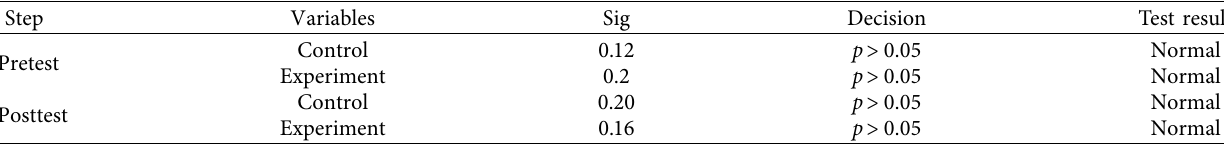
Table 14: Test table for normality of variables in the pretest and posttest (the upper-intermediate group for writing skill). Step Variables